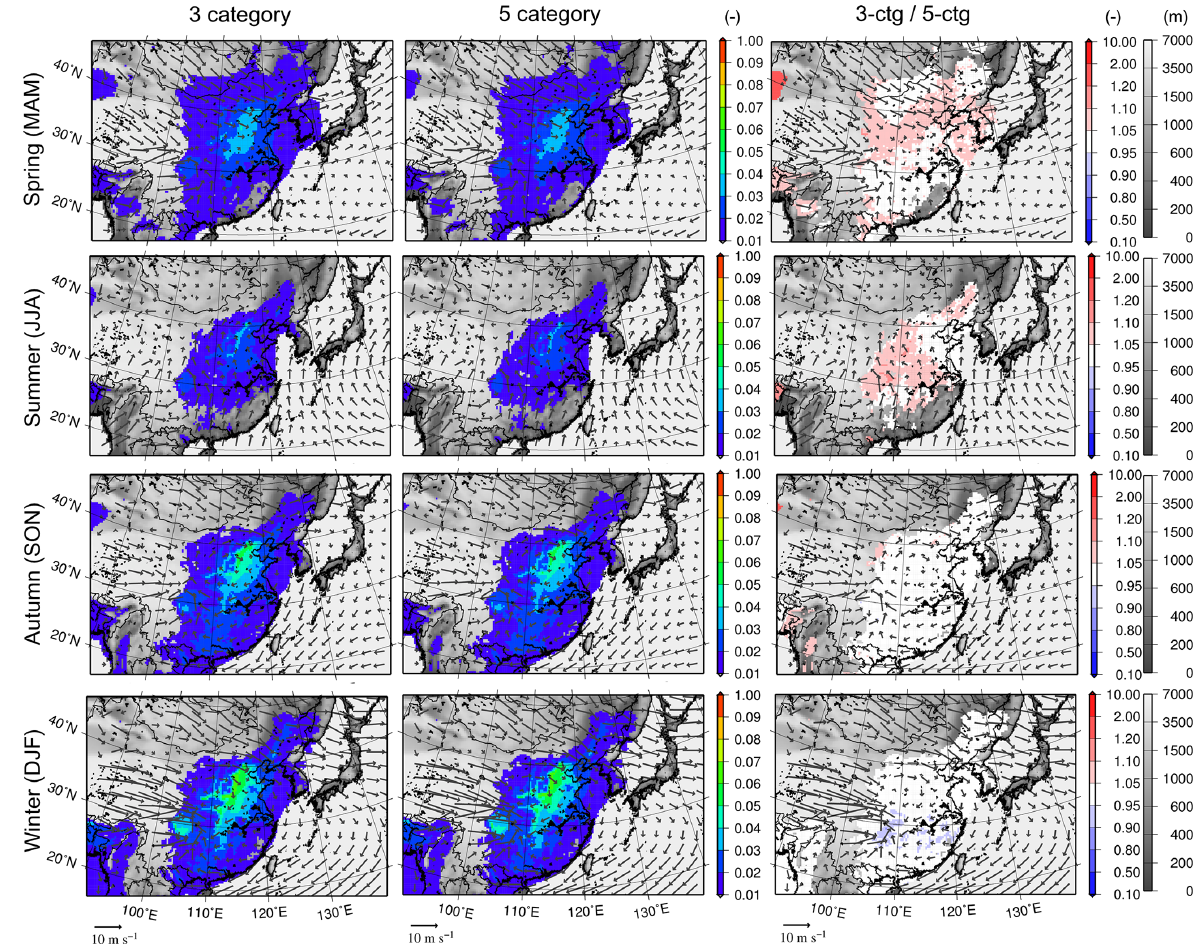
Figure 9. Seasonal mean AAOT (at 500nm) in (top to bottom) spring, summer, autumn, and winter of 2006 for (left to right) the three- category method and the five-category method and the corresponding ratio of the three-category to five-category